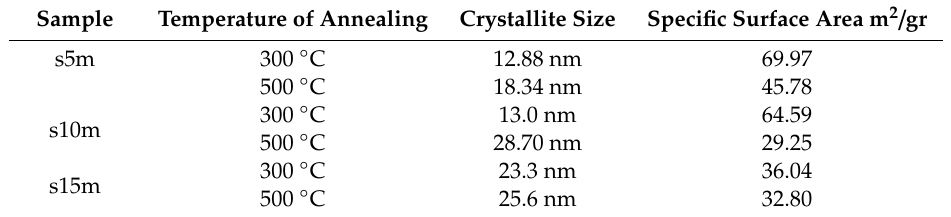
Table 2. Average crystallite size and specific surface area (SSA) of the WO 3 porous films for di ff erent annealing temperatures.